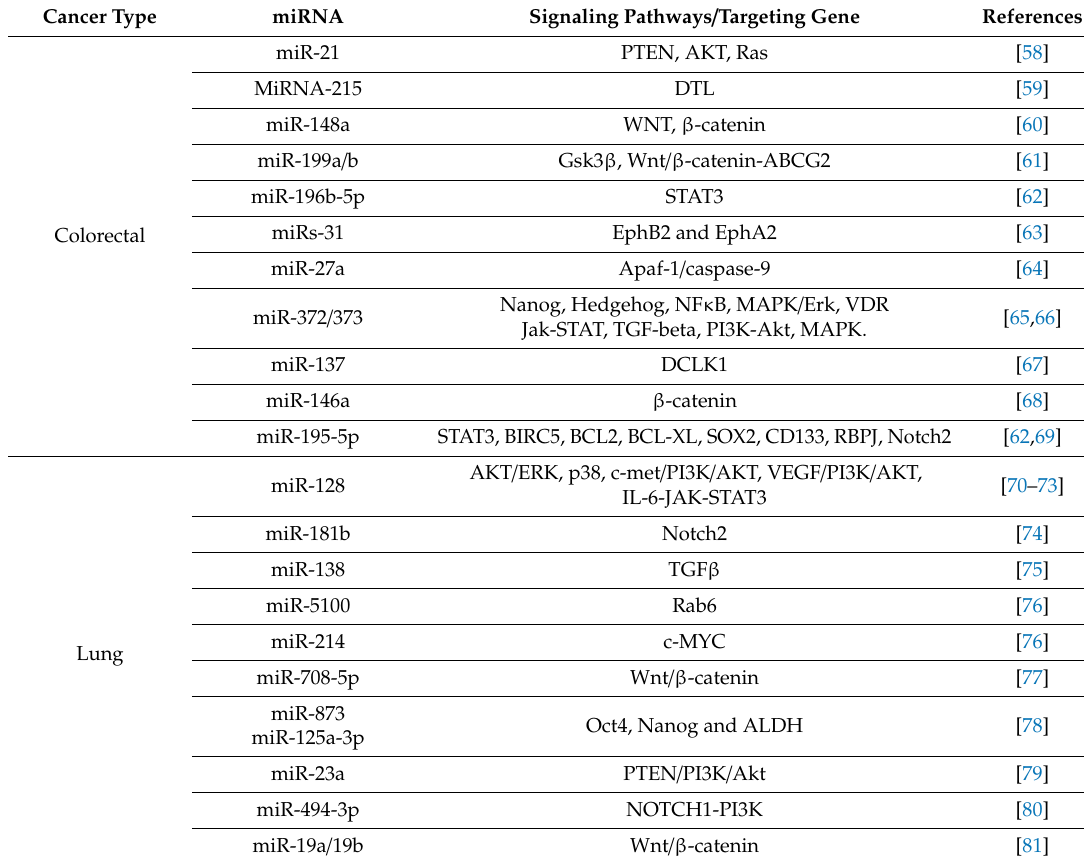
Table 1. The regulatory roles of miRNA in